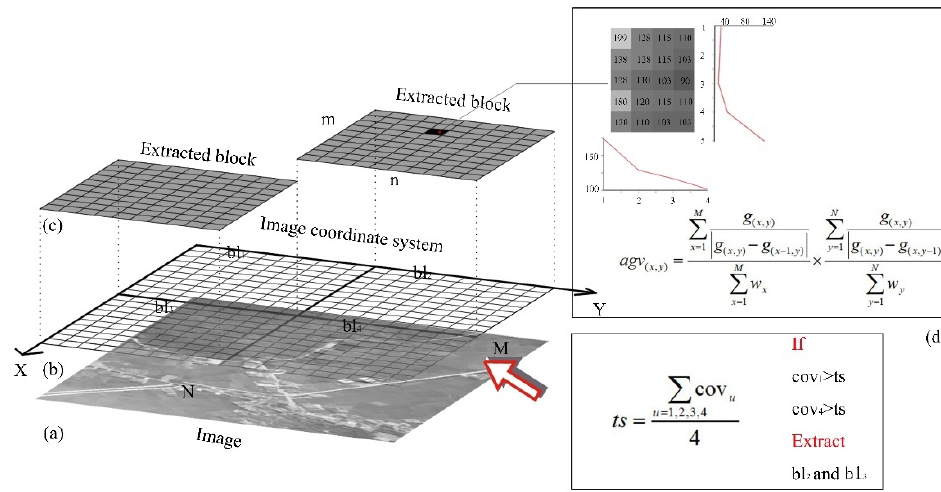
Figure 4. Block and extract: ( a ) original image, ( b ) creating coordinate system, ( c ) extracting blocks, ( d ) the example of calculate brightness compensation.